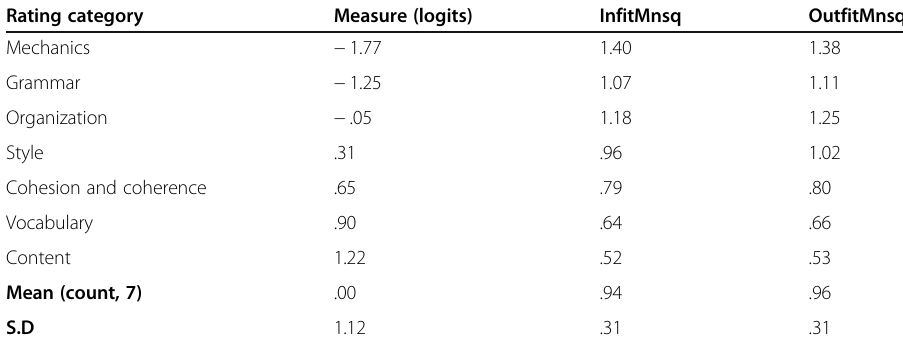
Table 4 Rating category measurement report — whole scale Rating